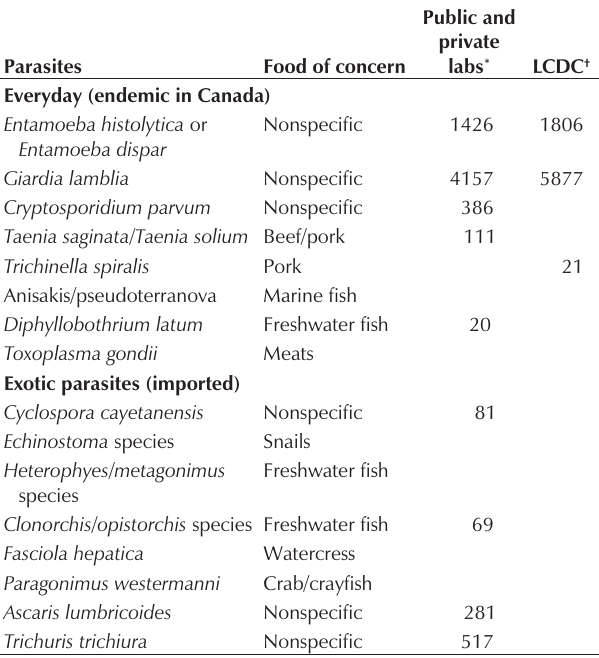
1997 in Ontario